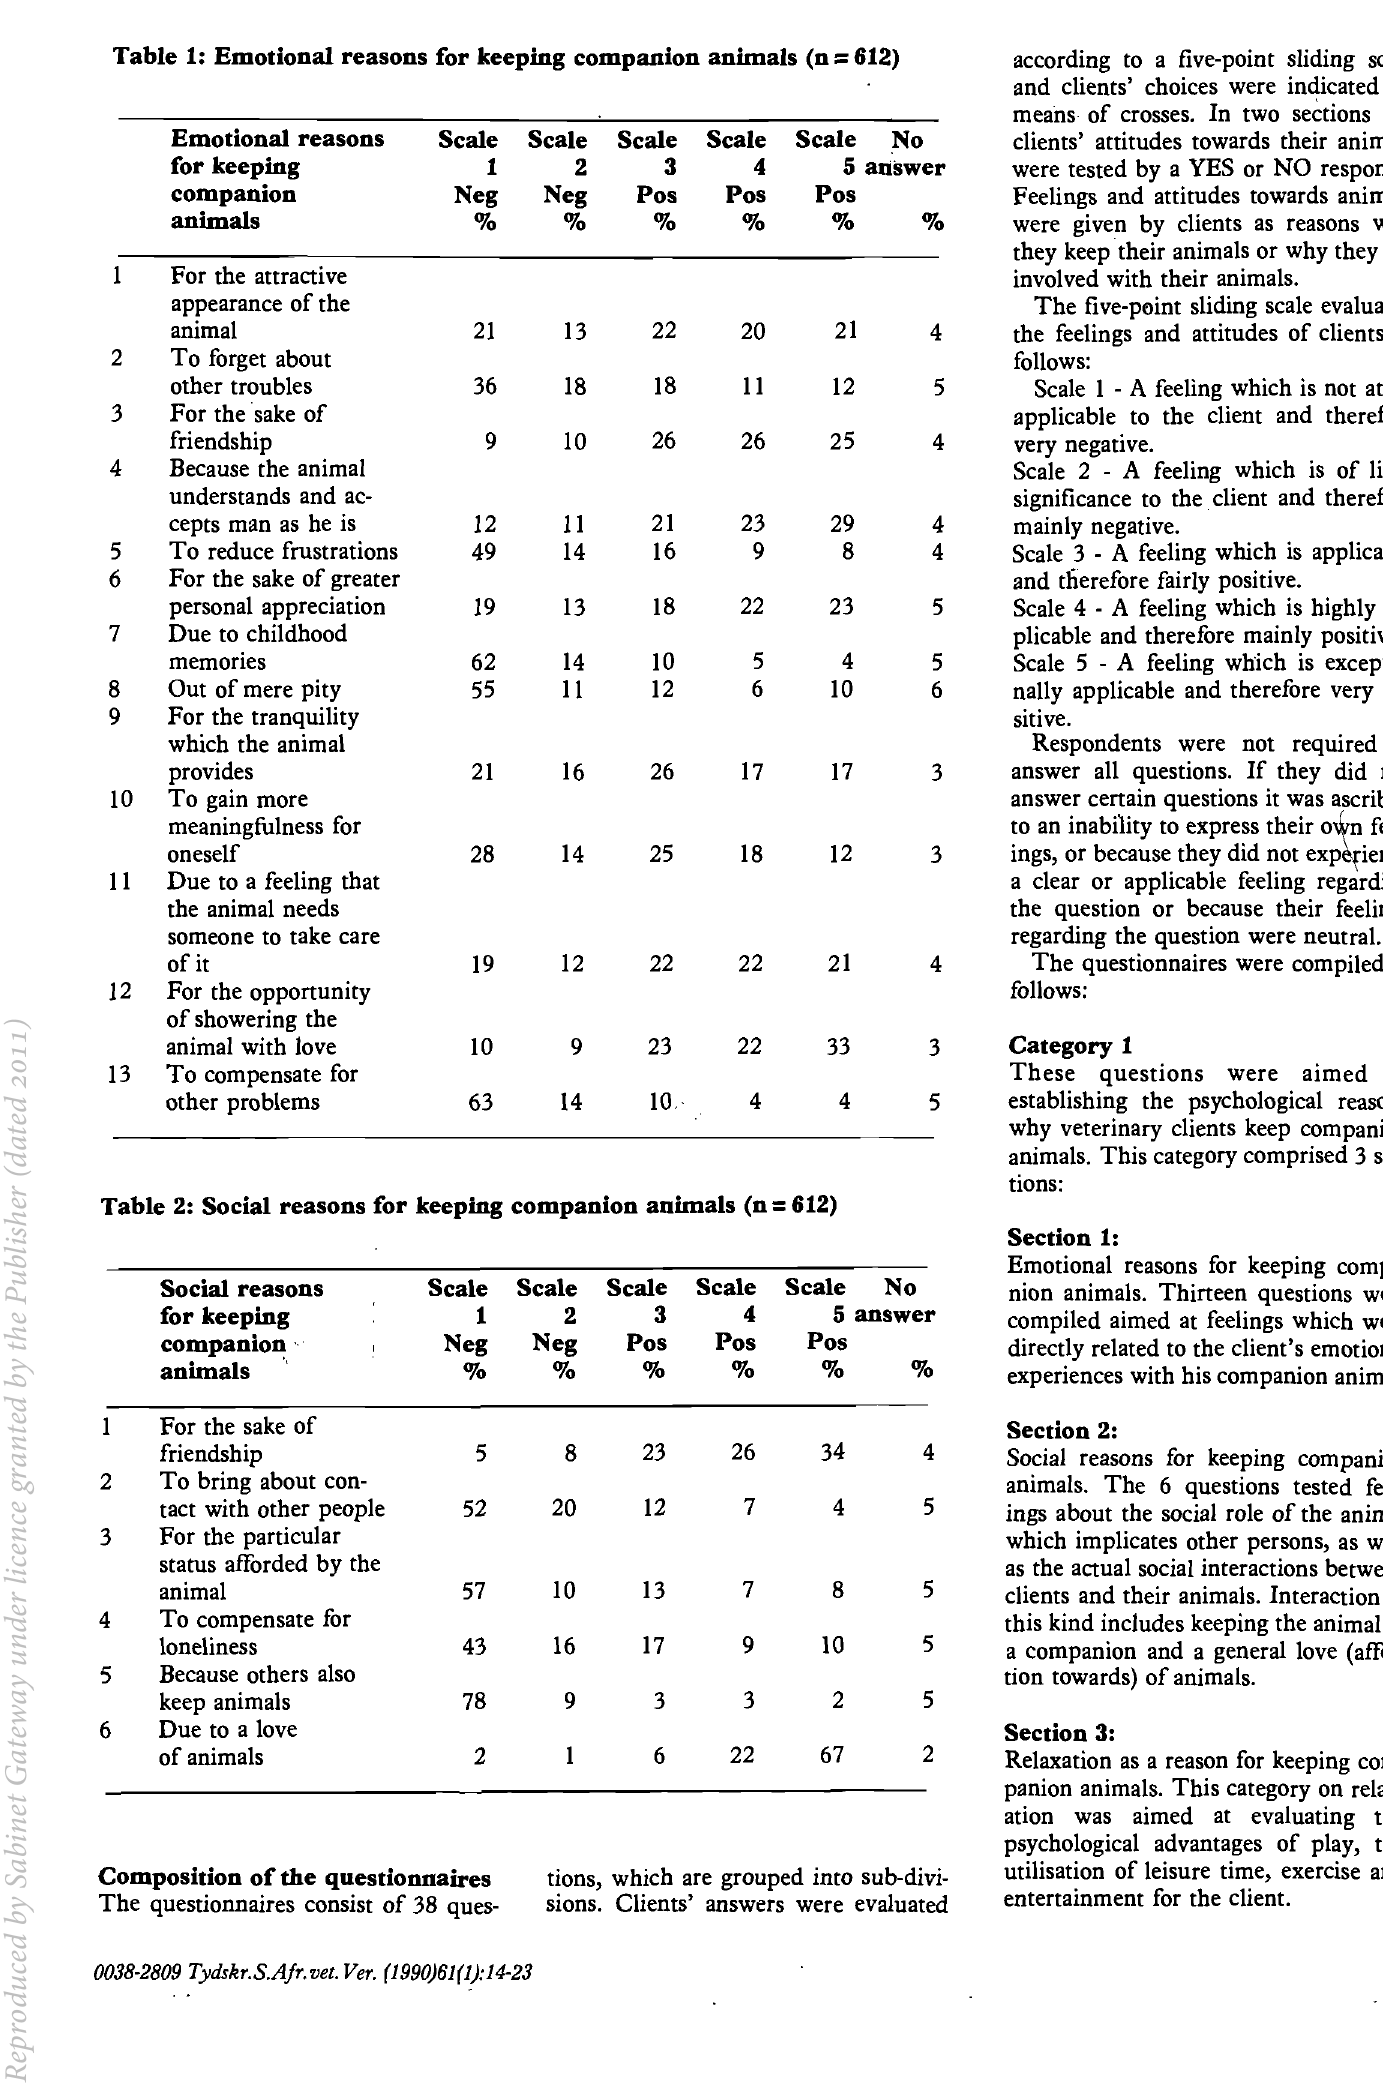
Table 1: Emotional reasons for keeping companion animals (n Emotional reasons for keeping companion animals